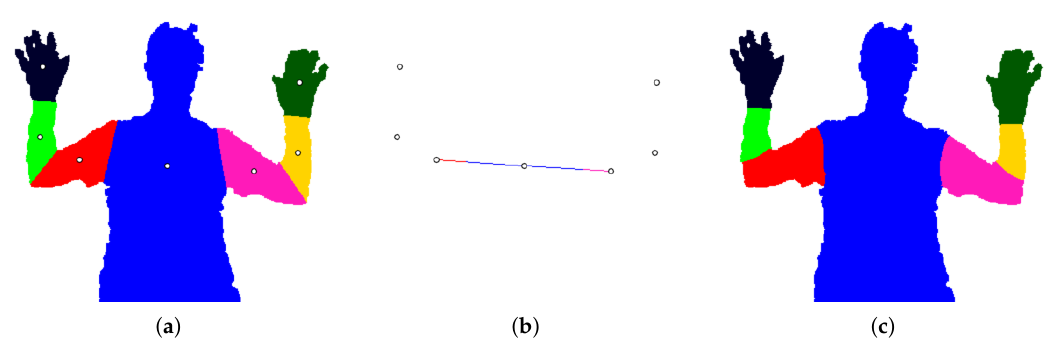
Figure 6. Segmenting with line seed pixels. ( a ) Ground truth image and part positions. ( b ) A line of seed pixels is drawn from the torso to each upper arm position. The first 2/3 of the line is labelled torso, and the remaining pixels are labelled L/R upper arm. Each other part i receives a single seed pixel. ( c ) Final